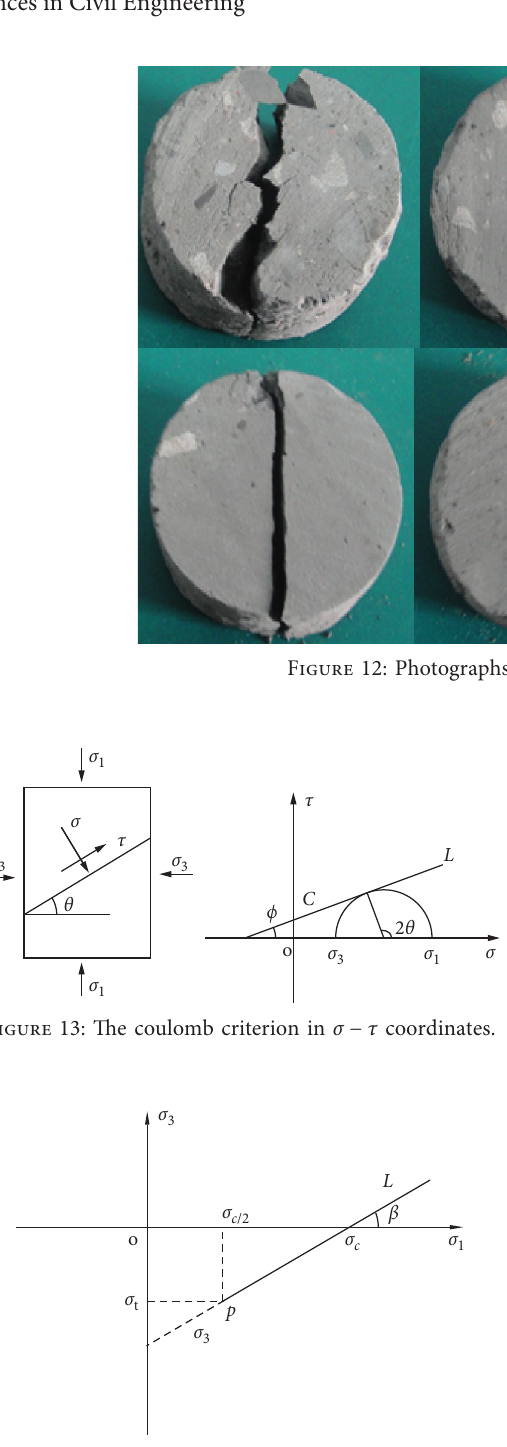
− σ coordinate system. 3 1